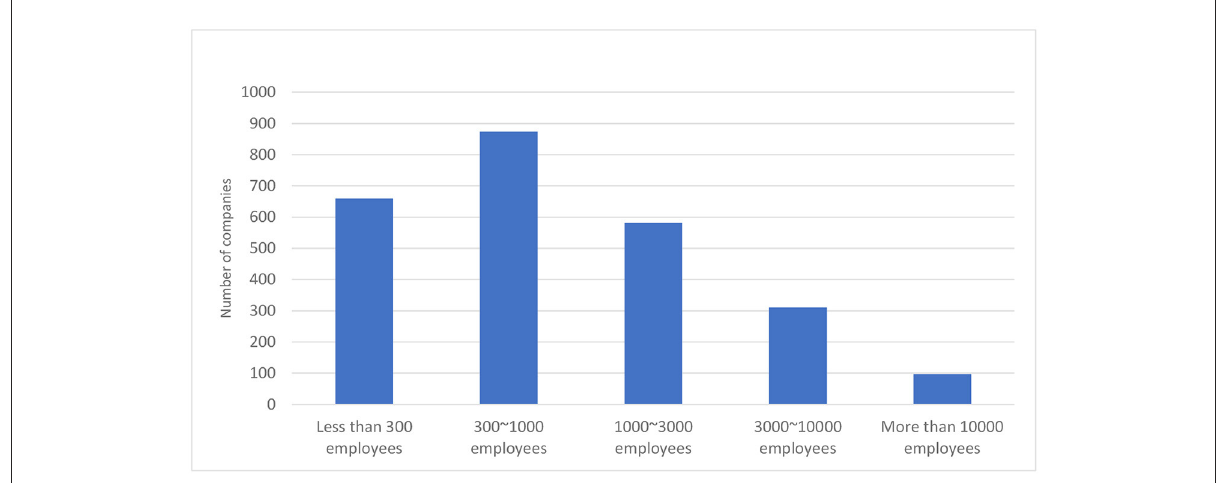
FIGURE3 Number of companies with different scales.